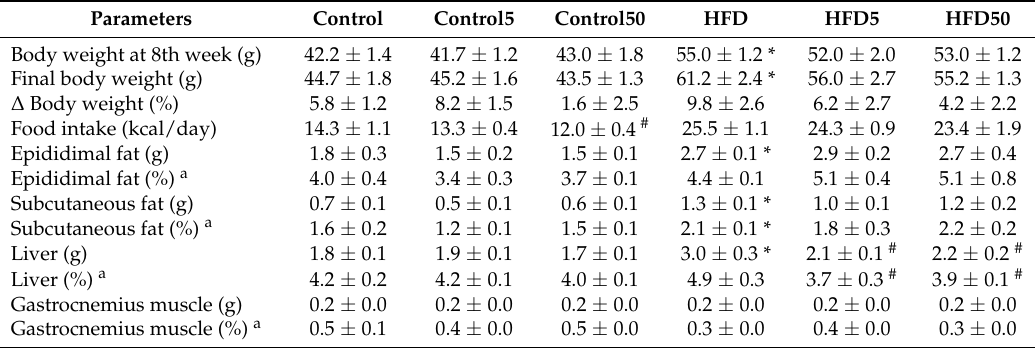
Table 2. Body weight and body composition of control mice, control mice treated with AERM 5